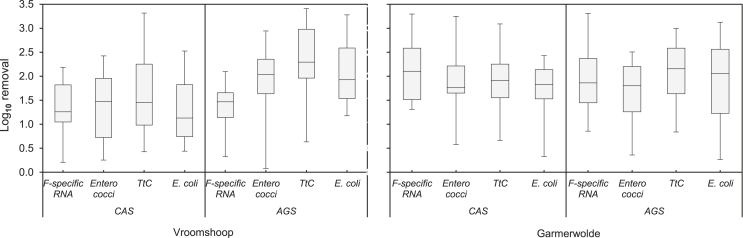
Log10 removal per treatment plant for AGS (left side) and CAS (right side) systems.